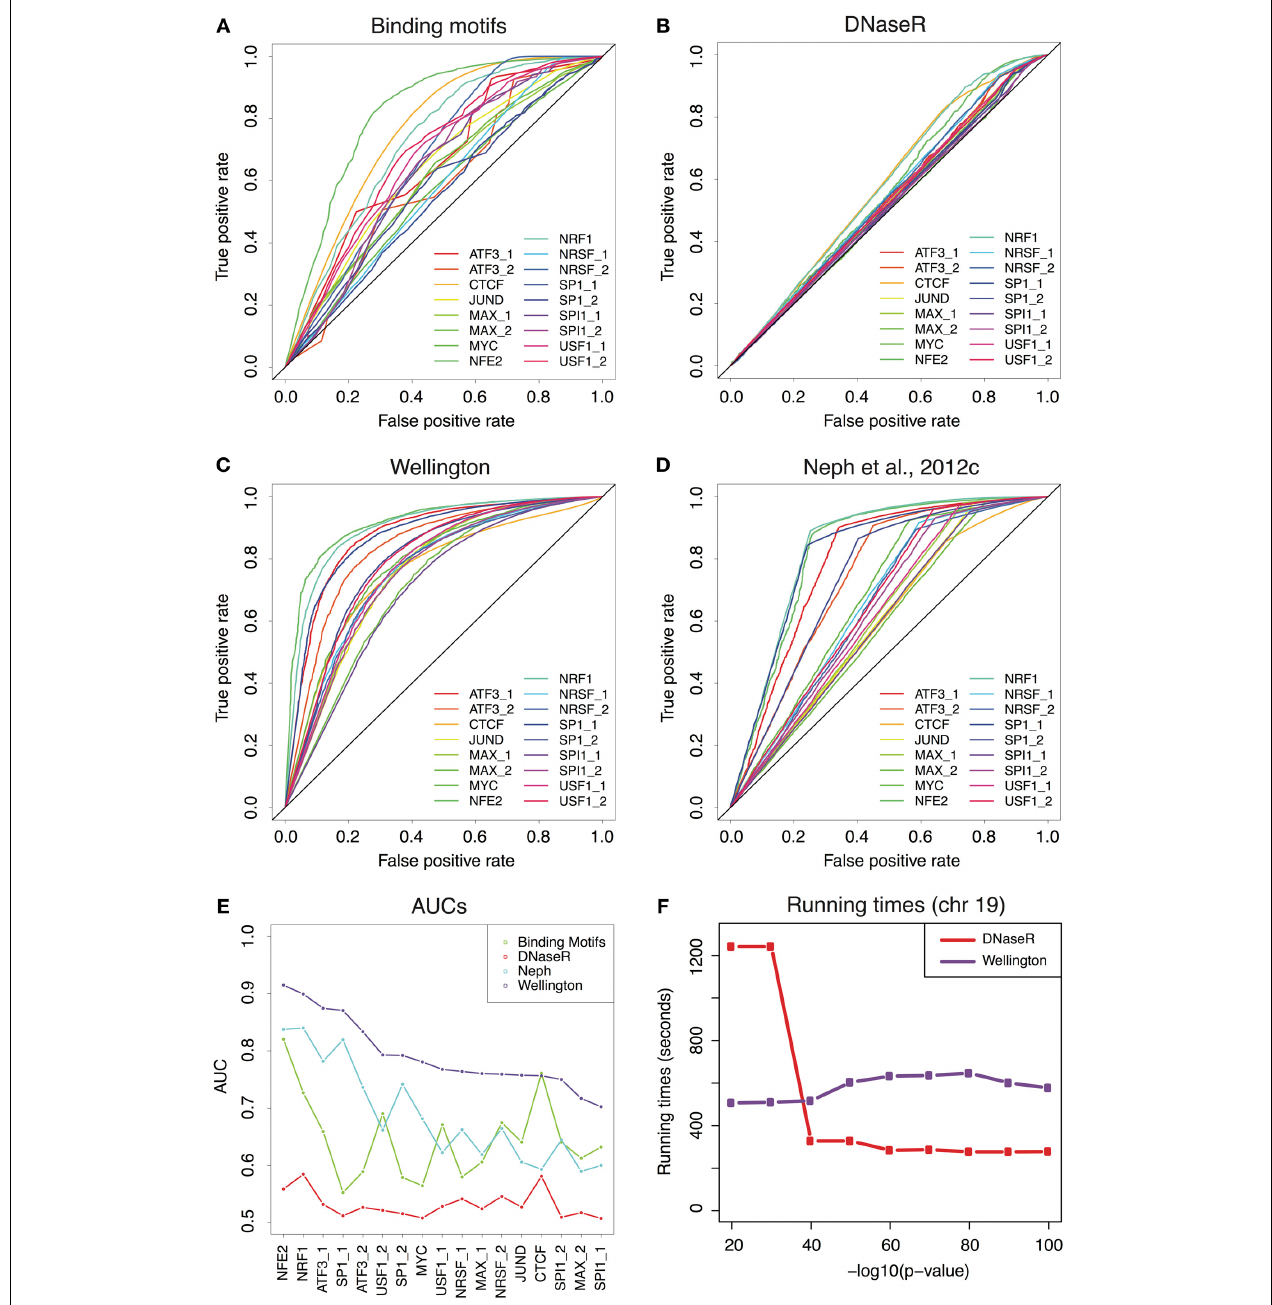
FIGURE 1 | (A) Receiver-Operator Characteristic (ROC) curves for the predictions provided by the binding motifs alone. (B–D) ROCs for the sets of footprints obtained by DNaseR, Wellington and for the set used in Neph et al.(2012c). (E) Area Under the Curve (AUC) corresponding to the ROCs of (A–D) Wellington scores consistently better than all theother methods. (F) Running times for DNaseR and Wellington on chromosome19, for different significance thresholds.